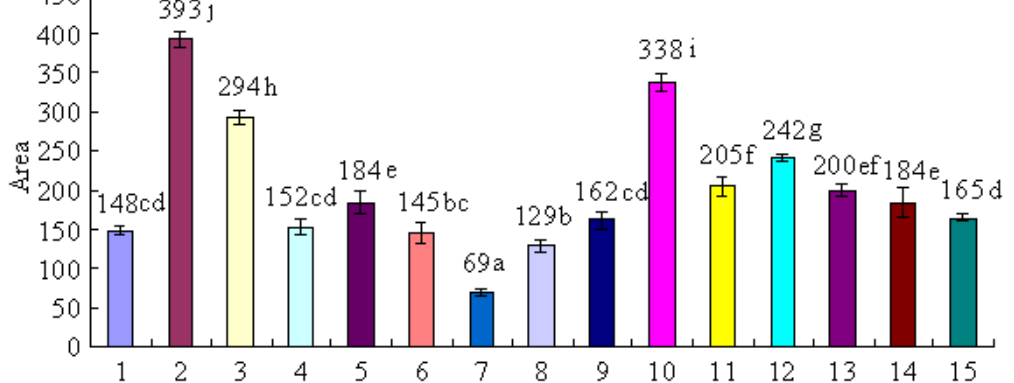
Figure 3. Comparison of antioxidant capacities of fifteen species of bamboo. Each value is the mean of triplicate measurements ± standard deviation. Different letters (a–j) on the top of the columns were significantly different ( p < 0.05). Different bamboo species (No. 1–15) are listed in Table 1. For the detailed protocol for evaluation of antioxidant activity see the Experimental